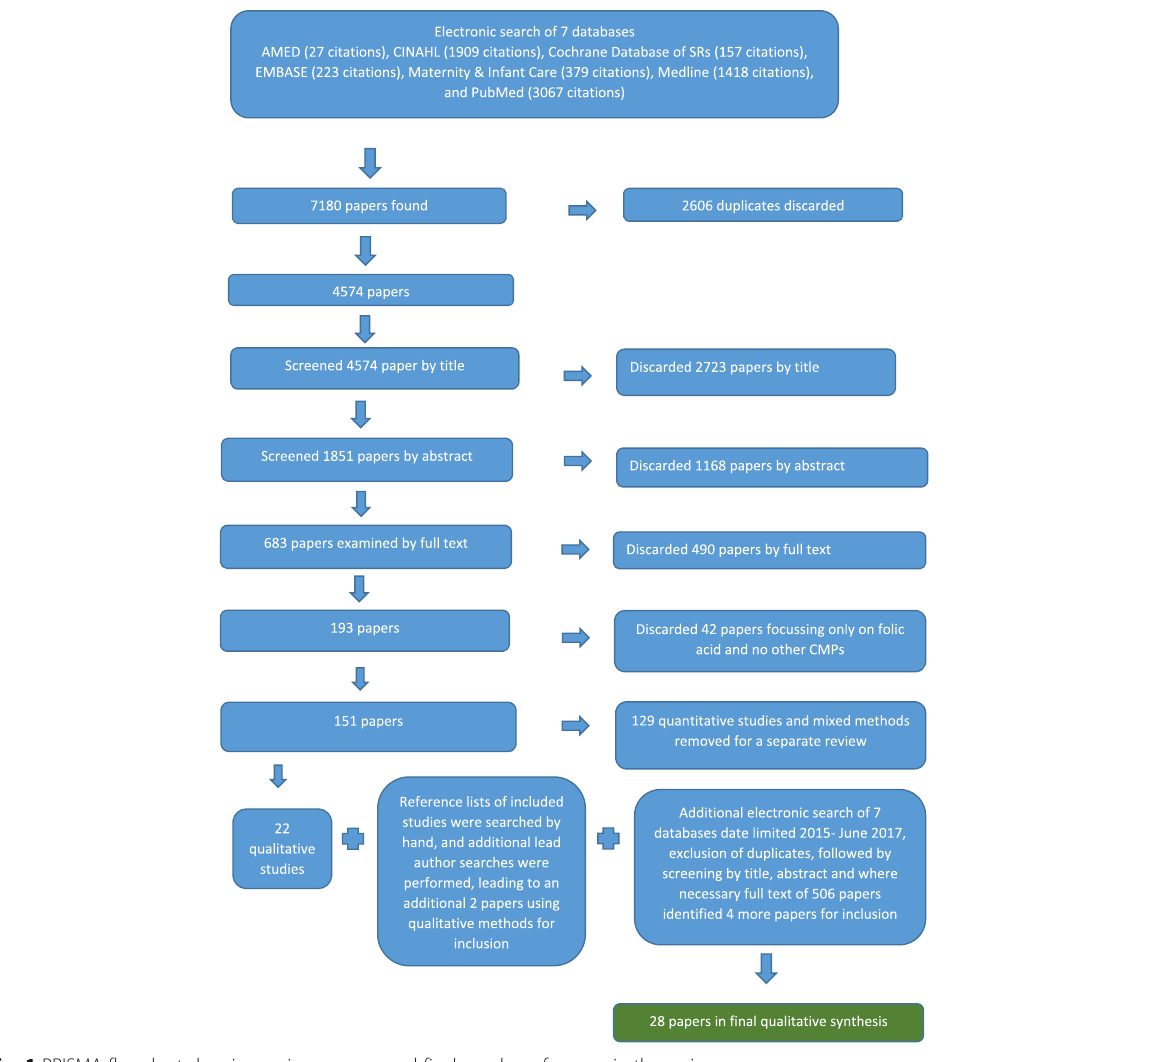
Fig. 1 PRISMA flowchart showing review process and final number of papers in the